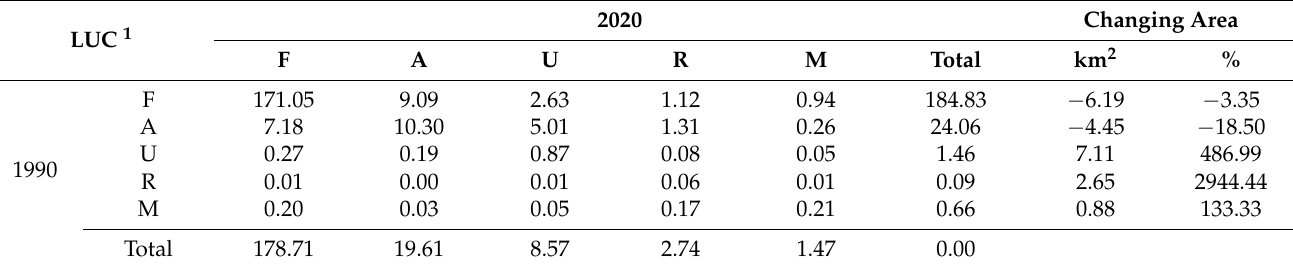
Figure 5. Land-use change dynamics map from 1990 to 2020 in Koh Chang, Trat Province. Table 4. Matrix of LUC in the Koh Chang area, 1990–2020 (km 2